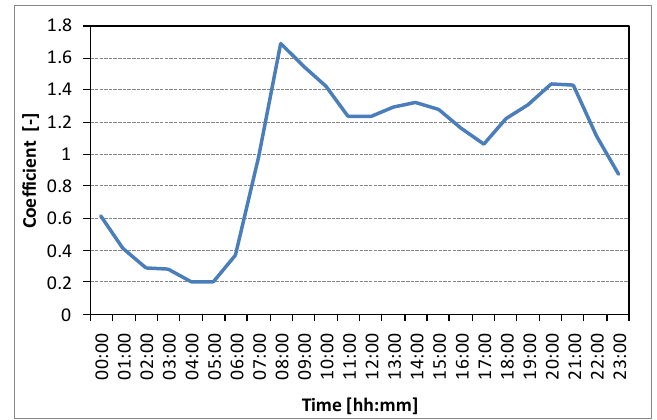
Figure 6. Wastewater daily patterns.